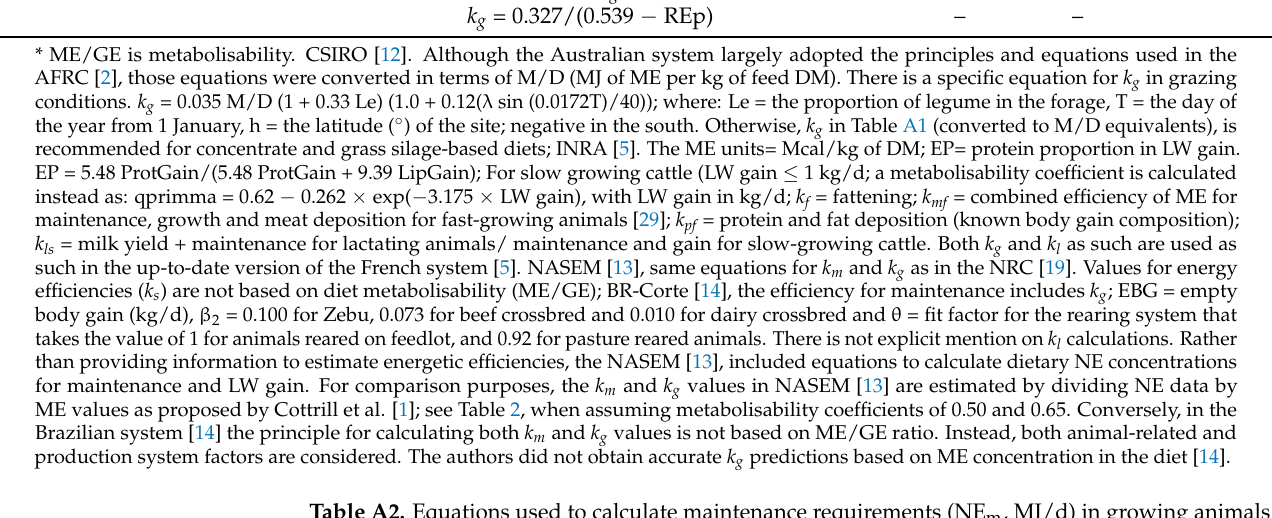
Table A2. Equations used to calculate maintenance requirements (NE m , MJ/d) in growing animals